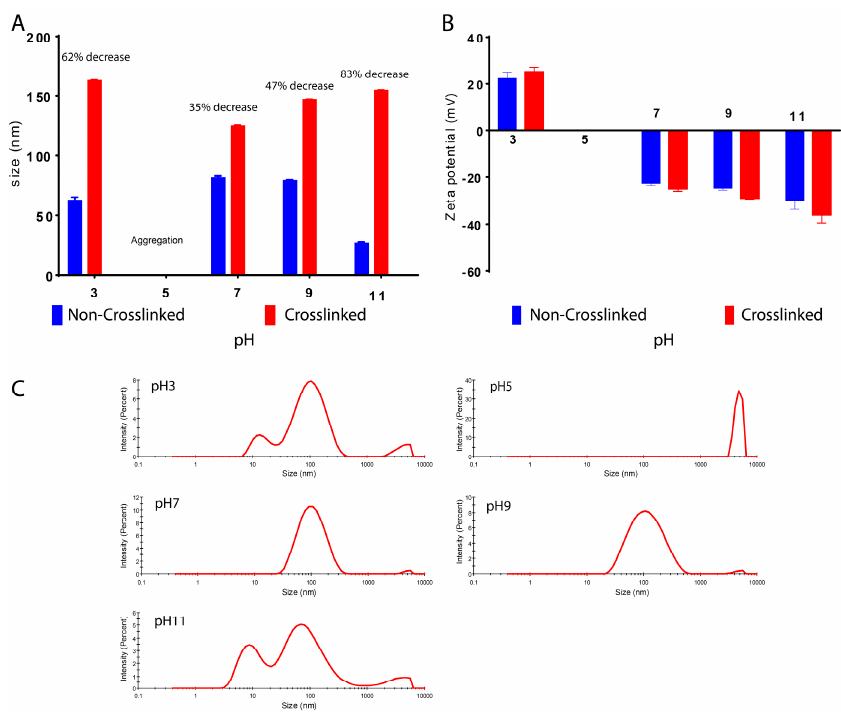
Figure 11. ( A ) Size of crosslinked and non-crosslinked BSA nanoparticles; ( B ) zeta potential; and ( C ) size distribution of non-crosslinked BSA nanoparticles at different pH values.